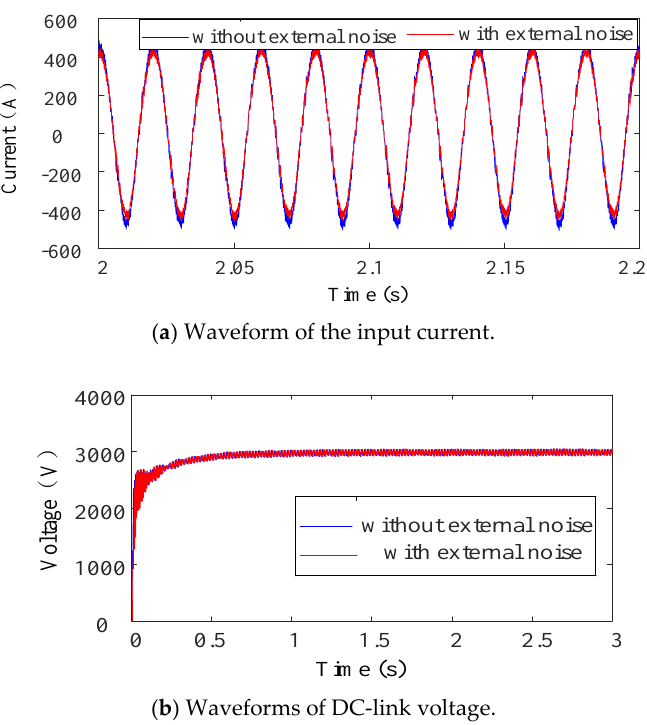
Figure 19. Waveforms of voltage and current of the convertor.